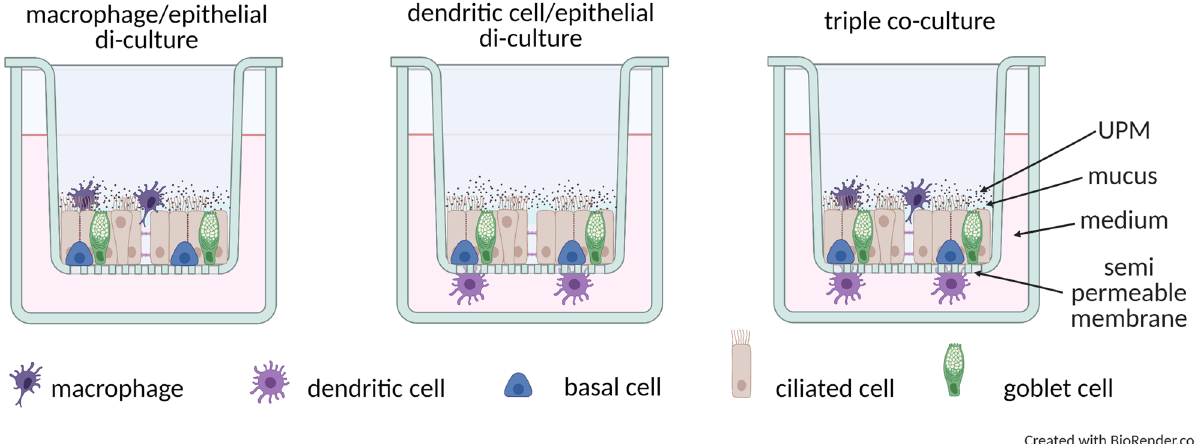
Figure 1. The scheme of di- and triple-co-cultures used in the